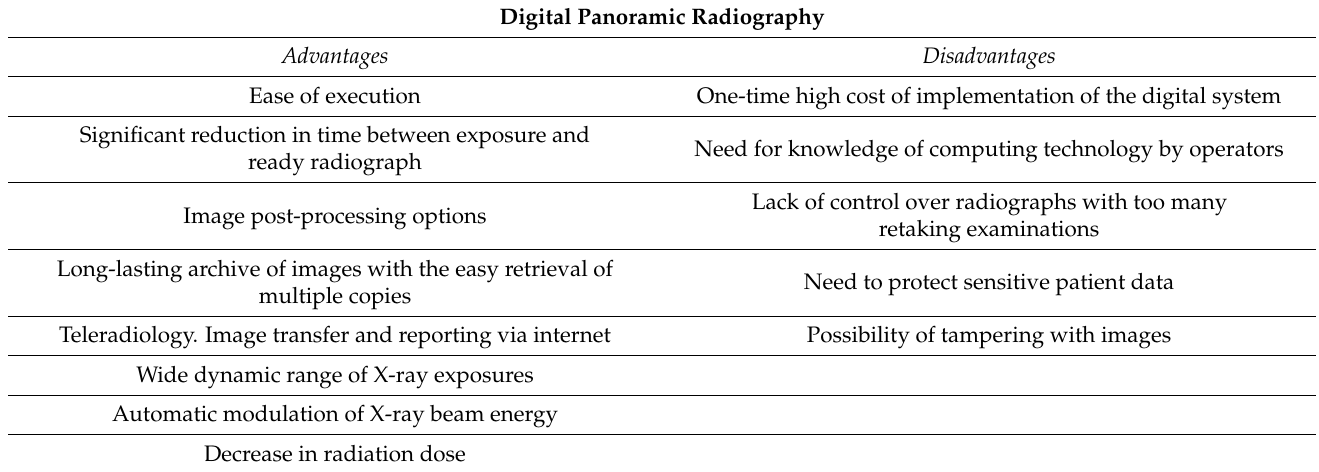
Table 1. Advantages and disadvantages of digital panoramic